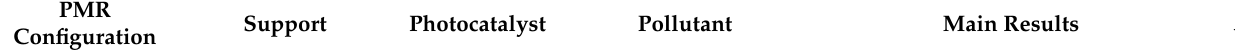
Table 2. Summary of various non-pressure driven PMR configurations in water treatment and their main results.